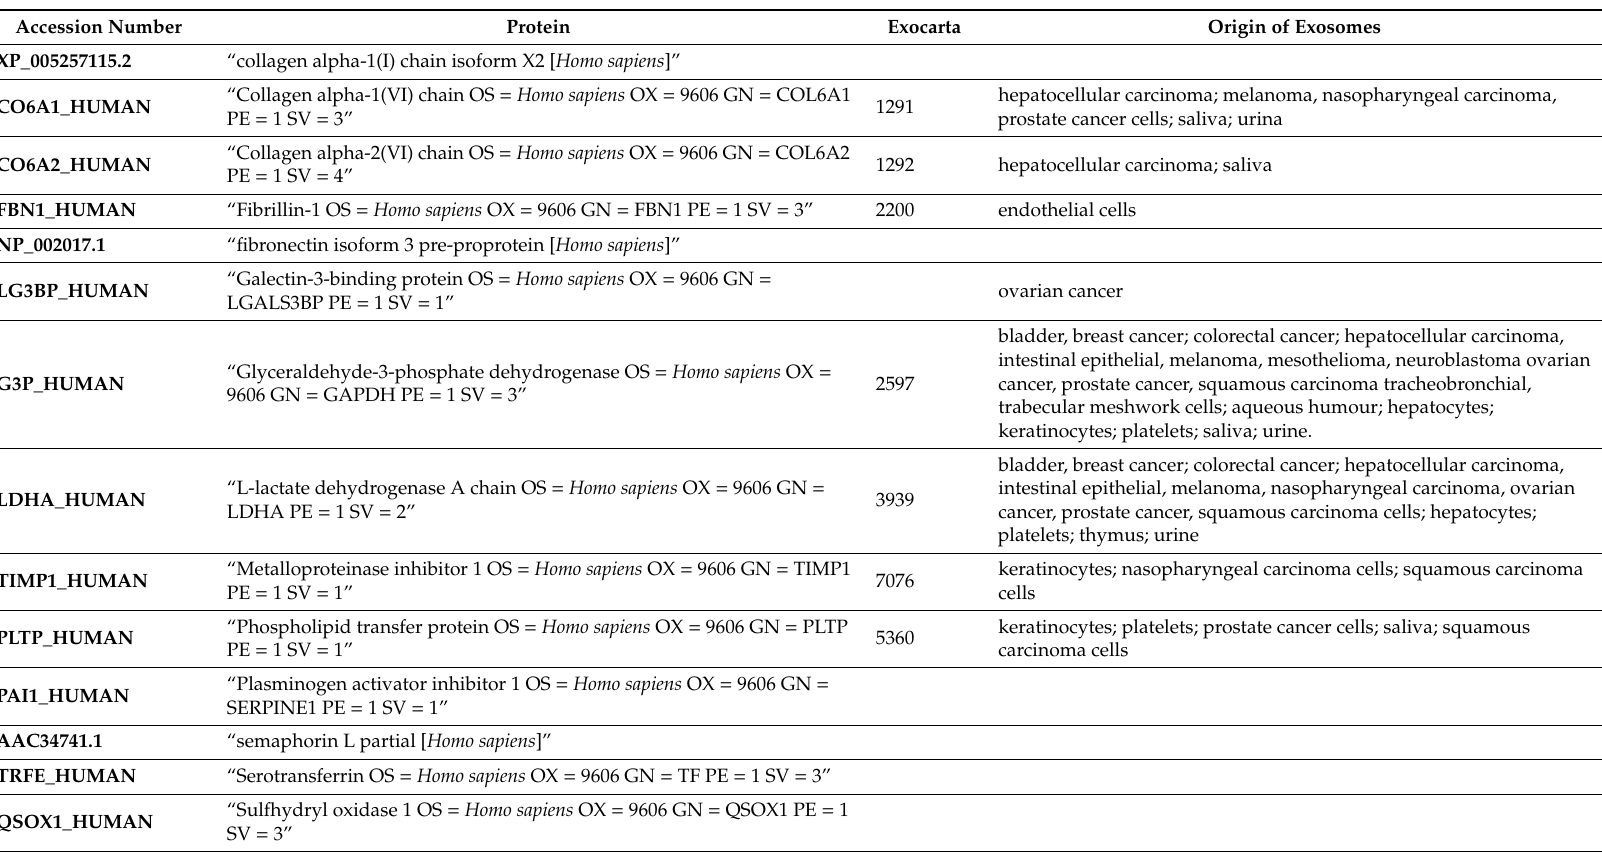
Table 1. List of 15 human proteins shared by two GASC-derived exosome preparations analysed by proteomics (Exo_S82, Exo_S104). Seven proteins were already described in Exocarta database and shown in the right column is a list of sources of exosomes in which they were observed. In bold are highlighted the six proteins not previously referenced in